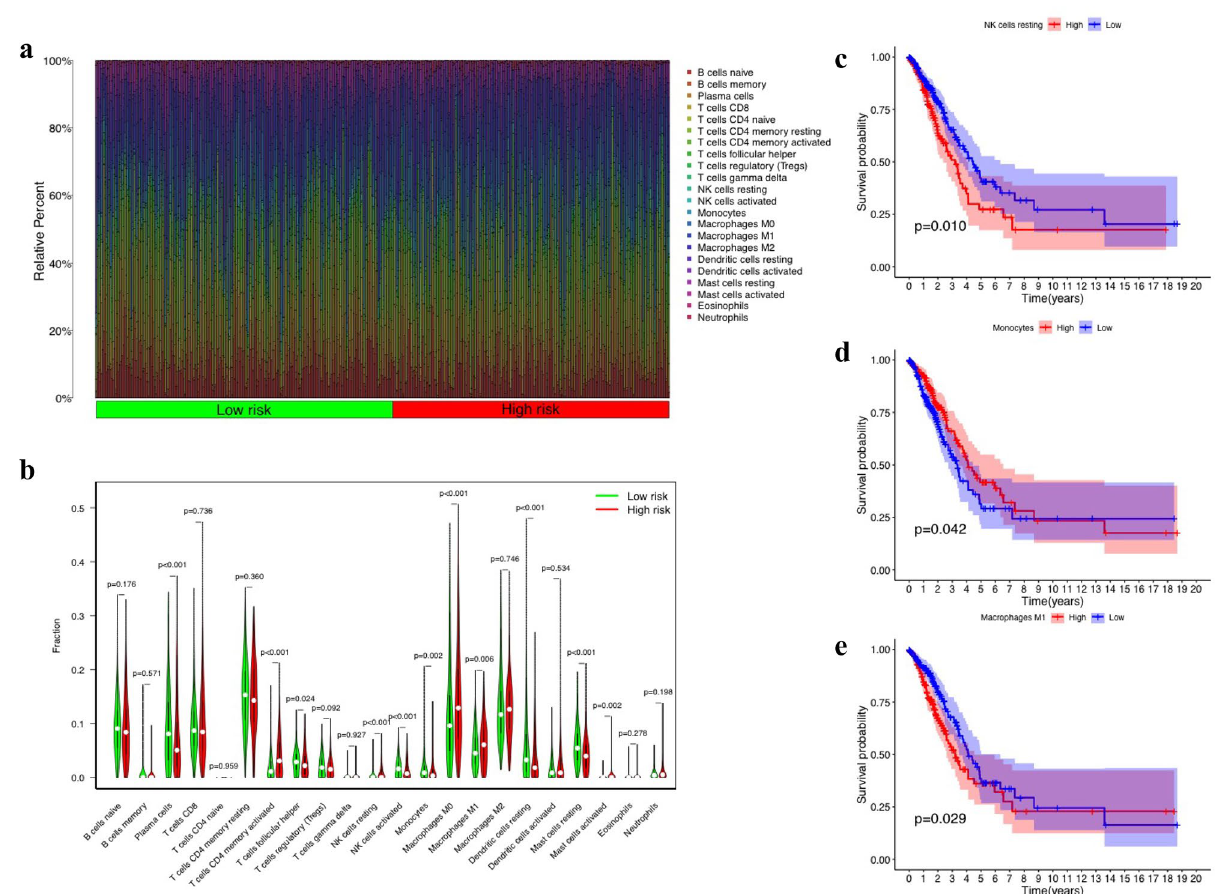
Figure 4. Differences in the immune microenvironment of the high and low-risk patients. ( a ) Heat map of immune cell expression between the high and low-risk populations. ( b ) Statistics of differences in immune cell expression between two groups. ( c , d , e ) NK cells, monocytes, and Macrophages m1 were analyzed for differences between groups, respectively.